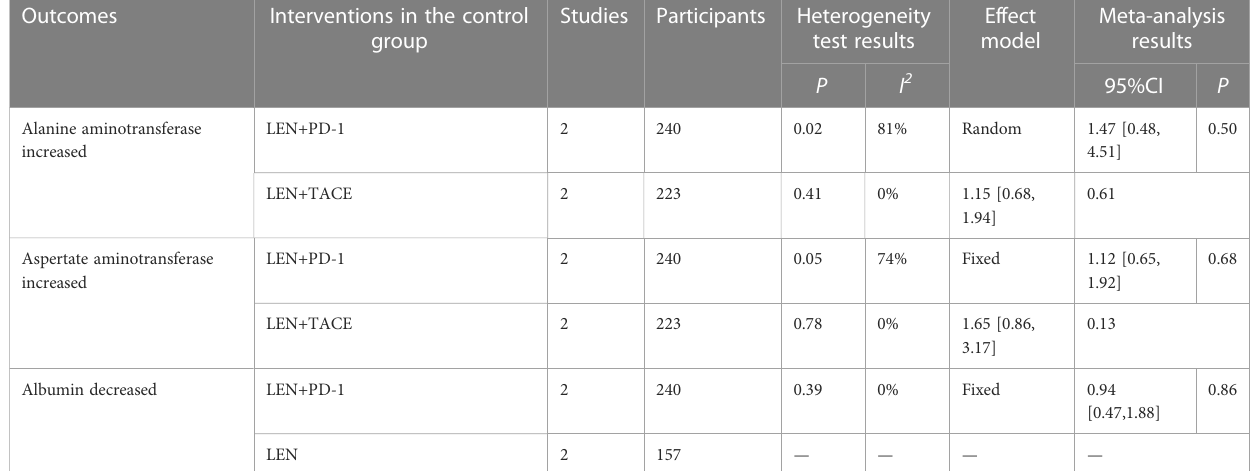
TABLE 6 Meta-analysis results of Laboratory-related AEs - Subgroup analysis.